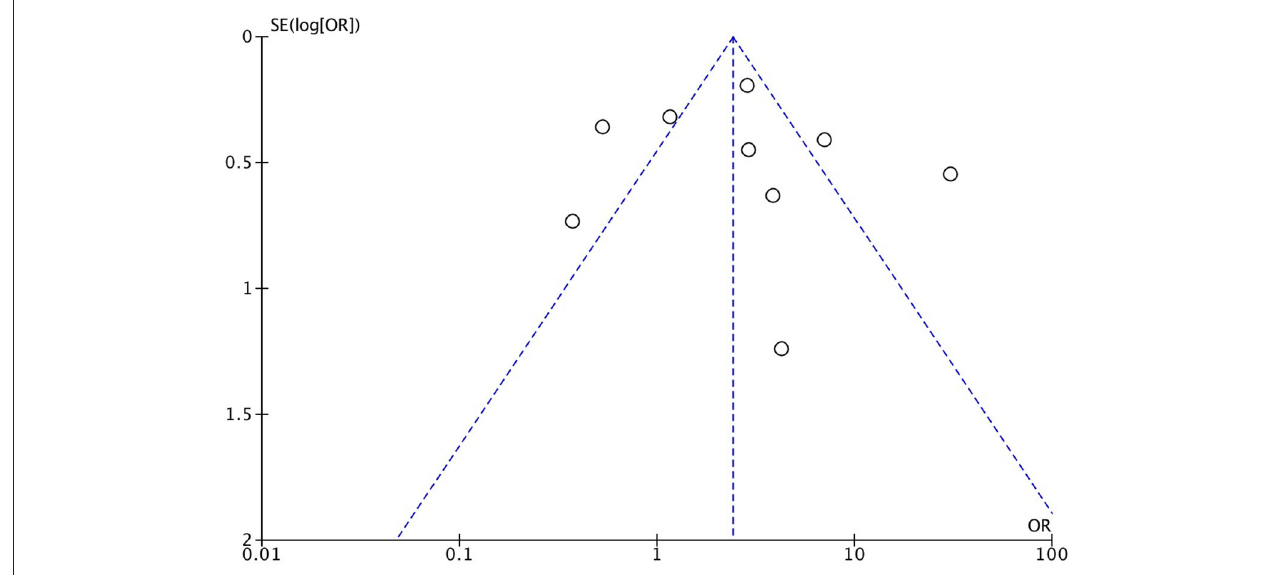
FIGURE 5 | Funnel plot for total revascularization rate.